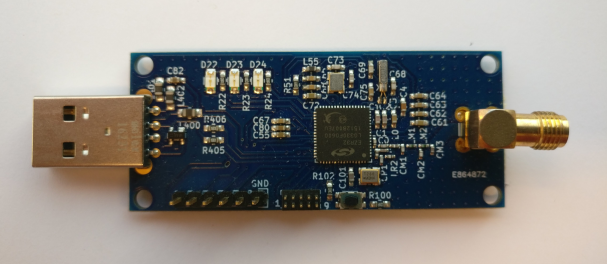
Figure 15. Hardware that is used in the iTower Gent environment for transmitter and